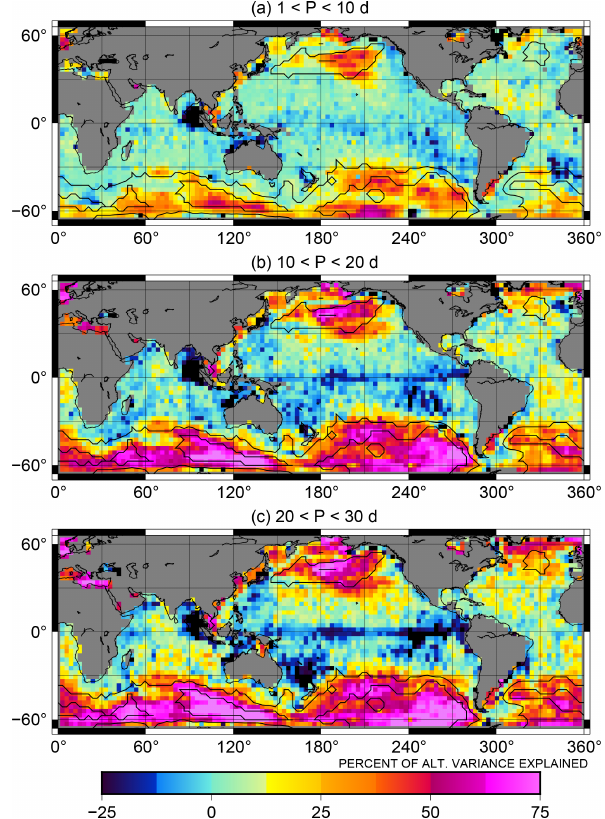
Figure 6. Percent of altimetric variance explained by the CSR swath series at three sub-monthly frequency bands: (a) periods below 10d, (b) periods between 10 and 20d, (c) periods between 20 and